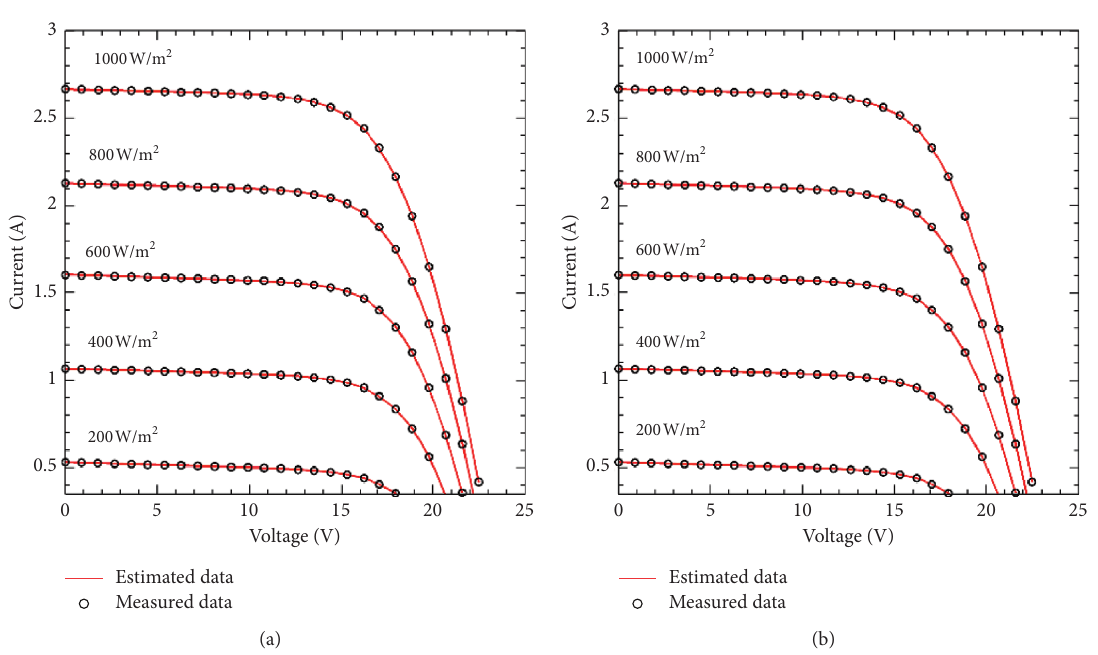
Figure 12: I-VC of (a) SDM and (b) DDM for thin-film ST40 at different irradiances.